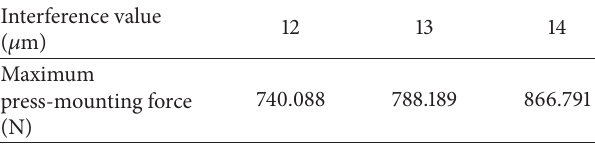
Table 7: Mean values of maximum press-mounting